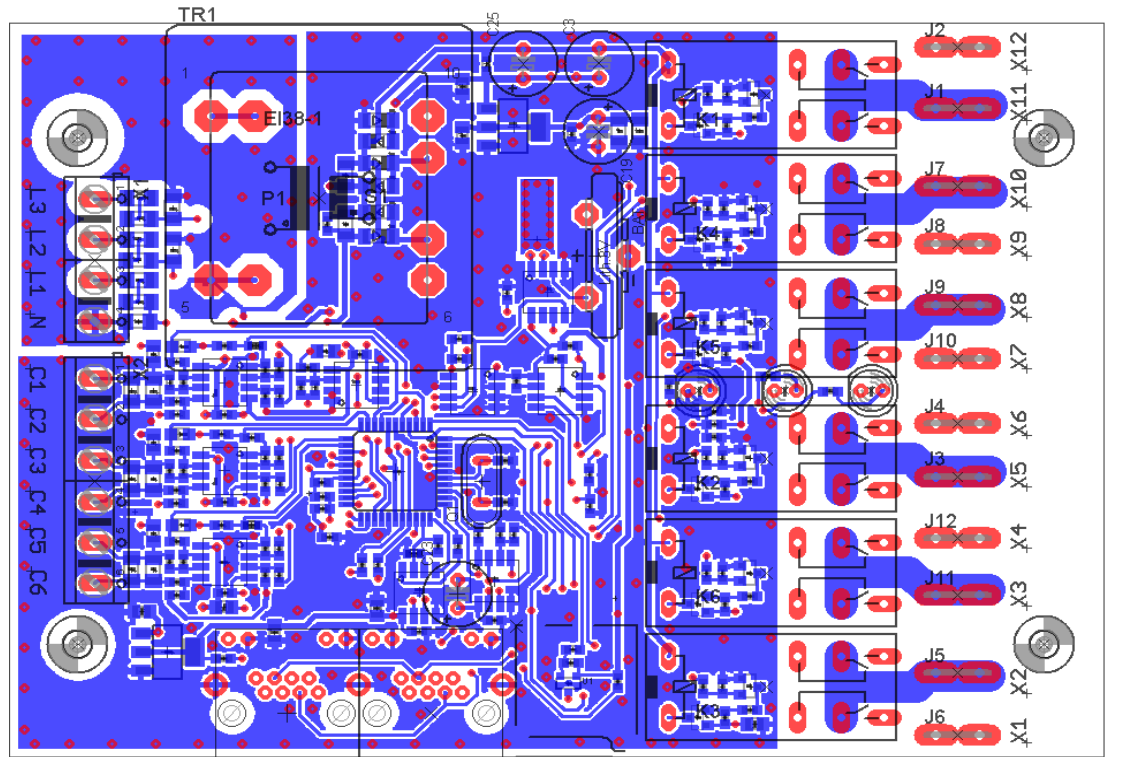
Figure 6. Analyzer PCB layout. Notice the spill GND